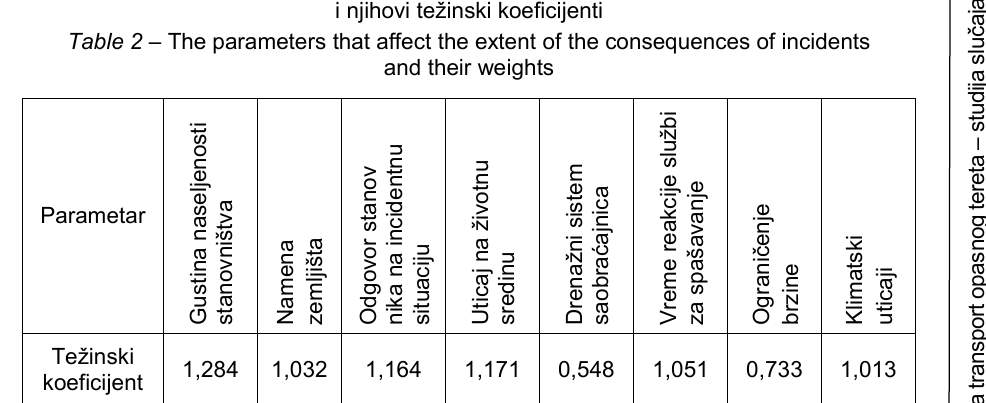
and their weights